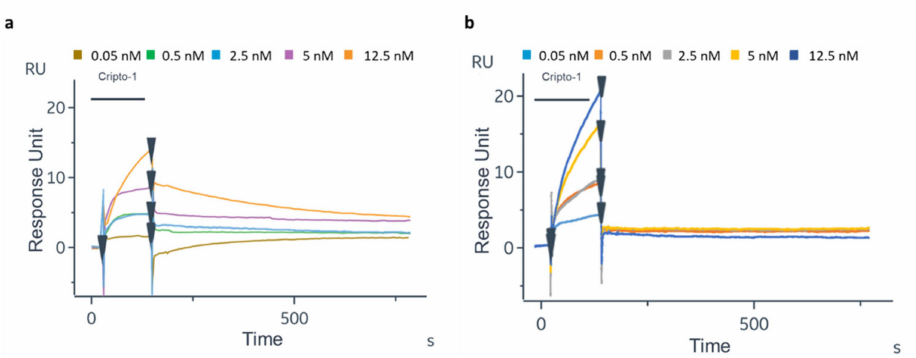
Figure 6. Sensorgrams related to the binding of Cripto-1 spiked at different concentrations (0.05–0.5–2.5–5–12.5 nM) in DMEM to oriented 1B4 ( a ) and to the same antibody randomly im- mobilized ( b